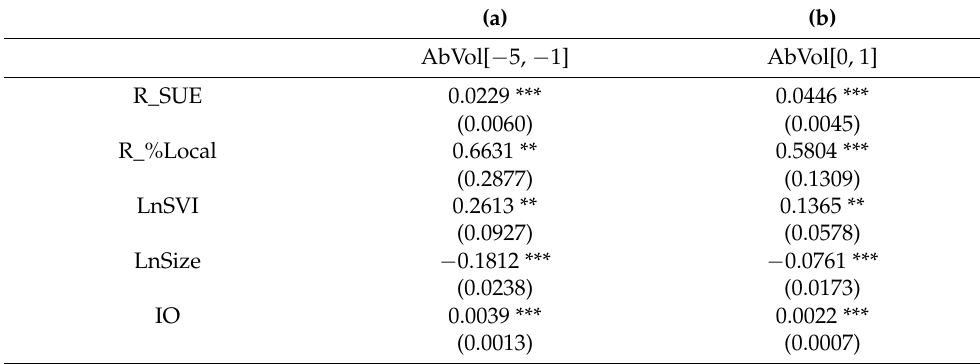
Table 13. Local Attention and Abnormal Trading